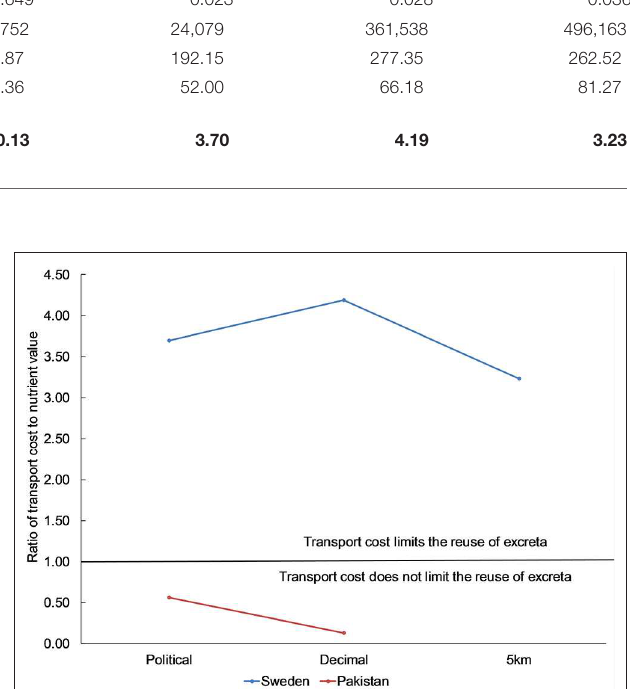
FIGURE 4 | Effect of increasing spatial resolution on the relative transport costs of surplus excreta nutrients to the value of those nutrients if they were purchased as synthetic fertilizer in Sweden (blue, higher line) and Pakistan (orange, lower